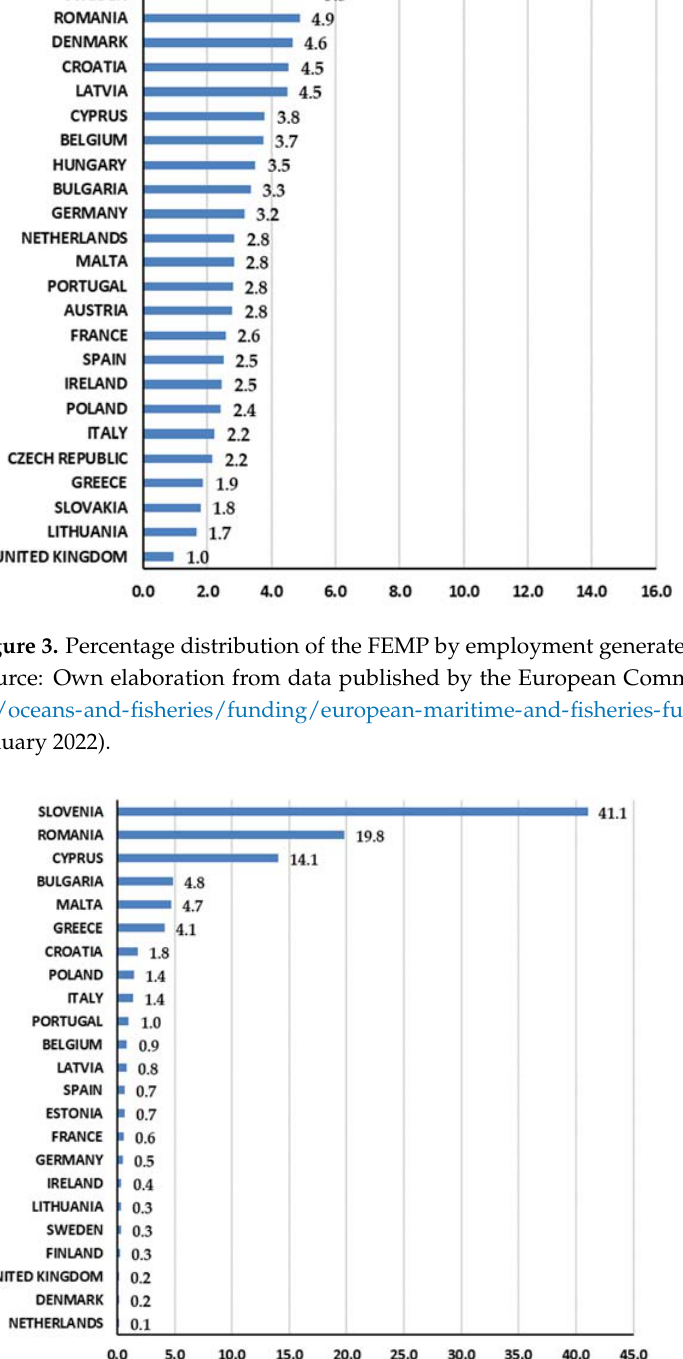
Figure 4. Percentage distribution of the FEMP by catches for the period 2014–2020. Source: Own elaboration based on data published by the European Commission and Eurostat. https://ec.europa. eu/oceans-and-fisheries/funding/european-maritime-and-fisheries-fund-emff_es (accessed on 11 January